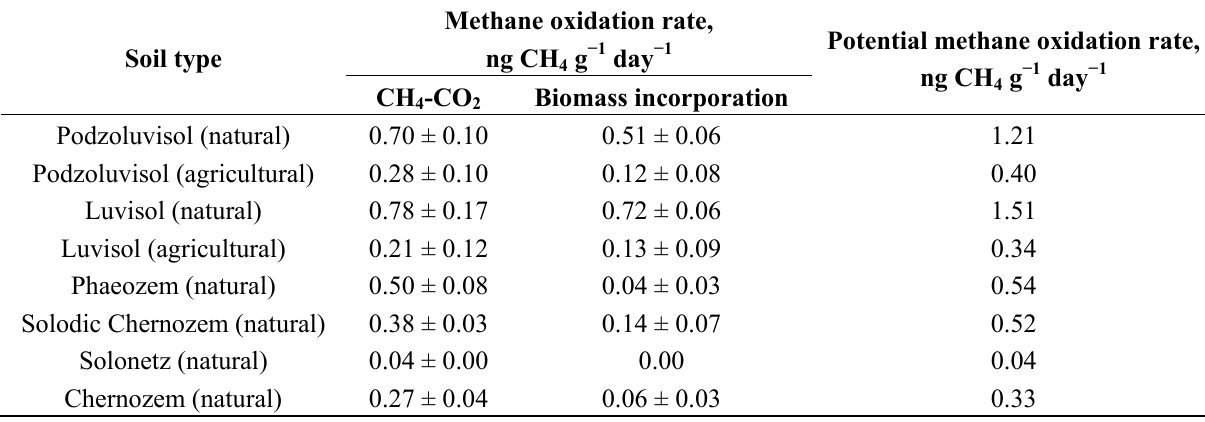
Table 2. Potential methane oxidation of the investigated